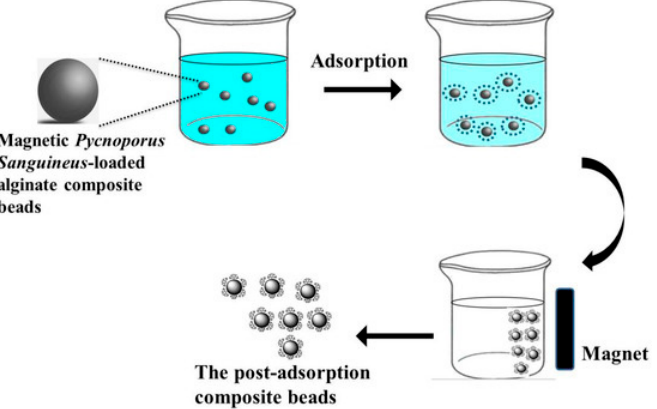
Figure 4. Schematic representation of the magnetic separation process. Reprinted from [25], with permission from Open Access MDPI, 2014.